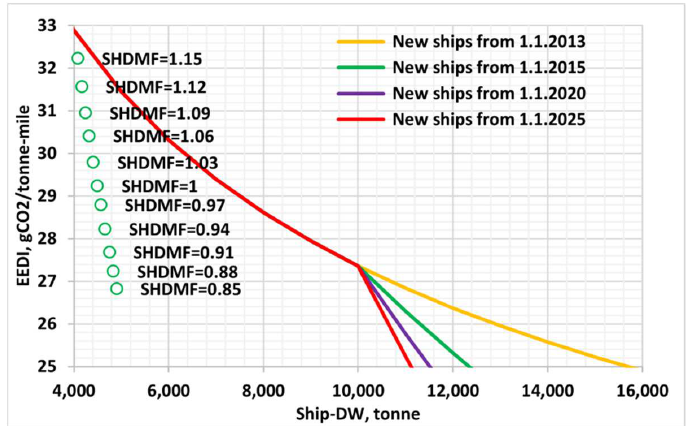
Figure 10. Energy efficiency design index.